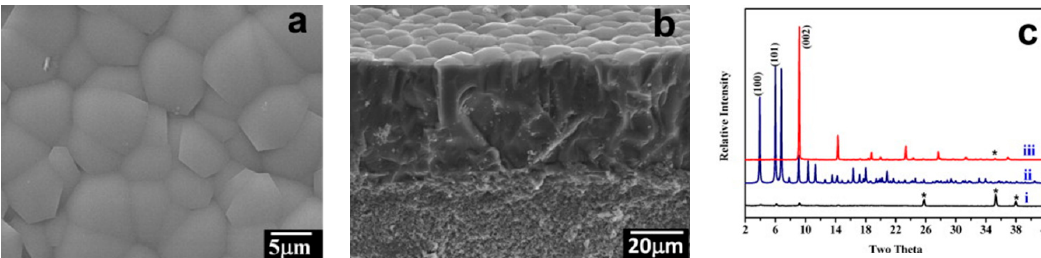
Figure 49. ( a ) Top view of ZIF-69 membrane by secondary growth. ( b ) Cross section view of ZIF-69 membrane by secondary growth. ( c ) XRD patterns for (i) ZIF-69 seeded α -alumina substrate, (ii) ZIF-69 powder by simulation from Mercury Software (Cambridge Crystallographic Data Centre), (iii) Highly oriented ZIF-69 membrane by secondary growth in this study. * are peaks from α -alumina substrate (adapted with permission from ref.